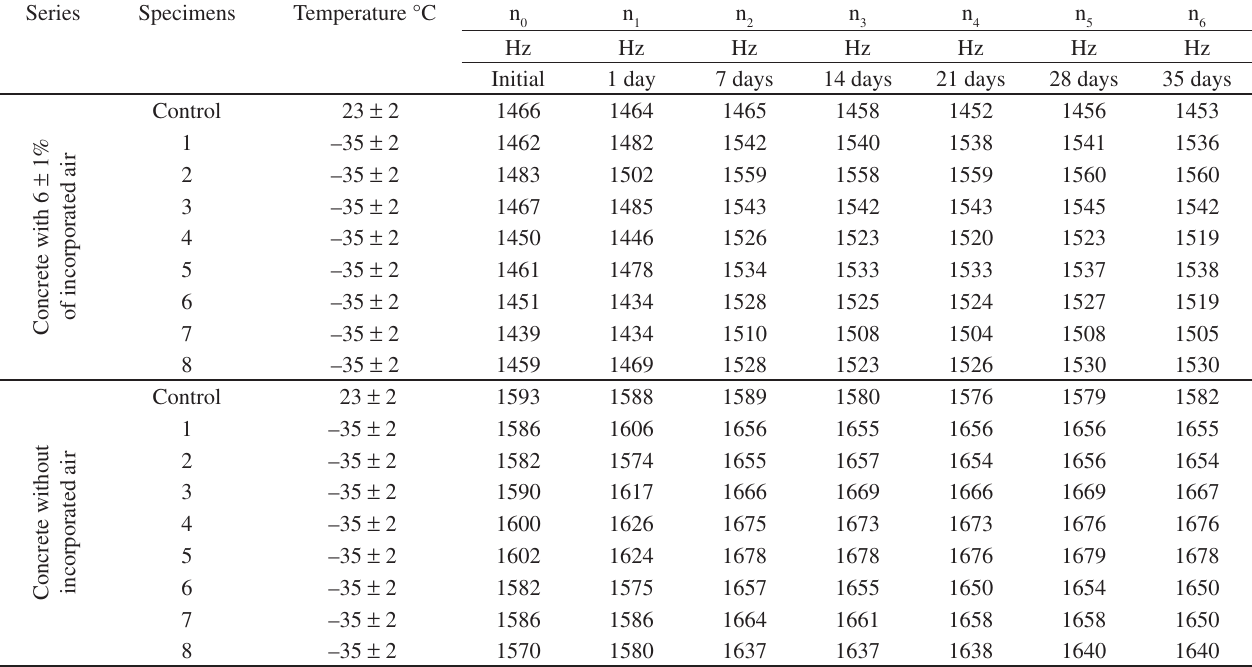
Table 5. Natural frequency obtained for the specimens at various ages. Series